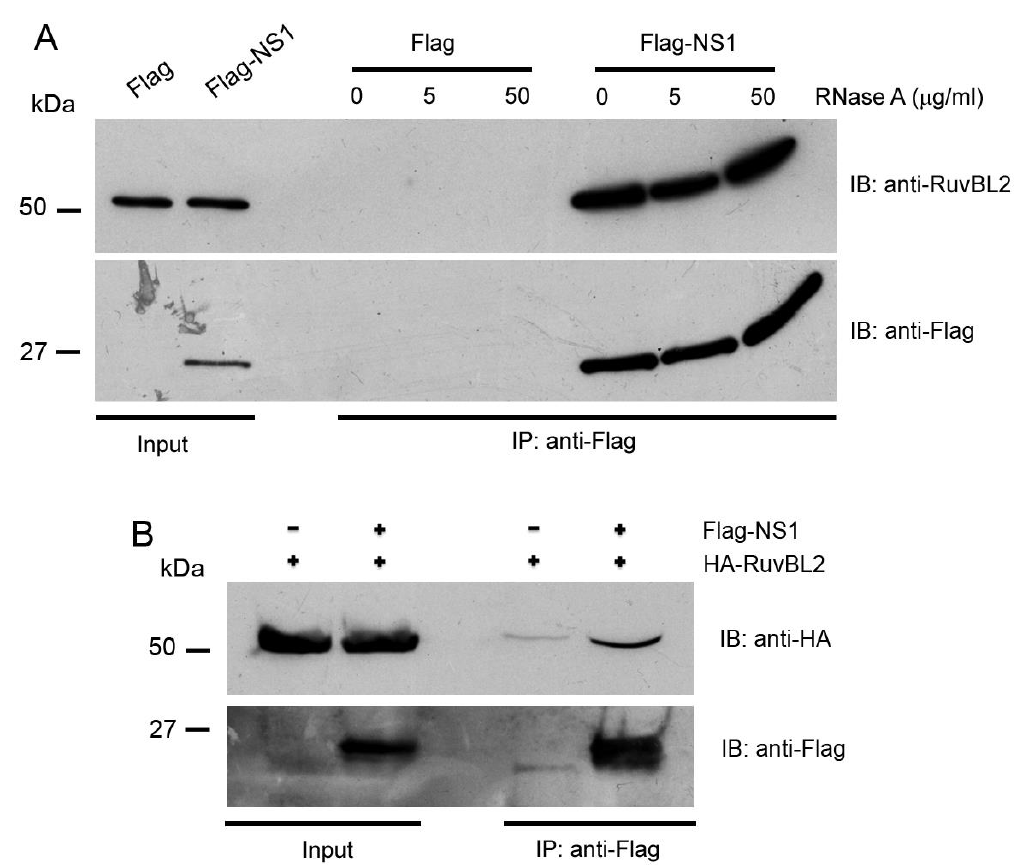
Figure 3. The NS1 interacts with endogenous RuvBL2 and the NS1-RuvBL2 interaction is RNA-independent. ( A ) The NS1 interacts with endogenous RuvBL2 and the NS1-RuvBL2 interaction is RNA-independent. Cell lysates of the cells expressing Flag alone and an endogenous RuvBL2, or the cells expressing Flag-NS1 and an endogenous RuvBL2 were pulled down by an immobilized anti-Flag antibody, and the precipitated proteins on beads were treated with the indicated concentrations of RNase A, washed, and the bound proteins were analyzed by Western blotting with the indicated antibodies. ( B ) RuvBL2 interacts with the NS1 of the seasonal IAV H7N9 virus. The experiment was performed similarly to that shown in Figure 2A.